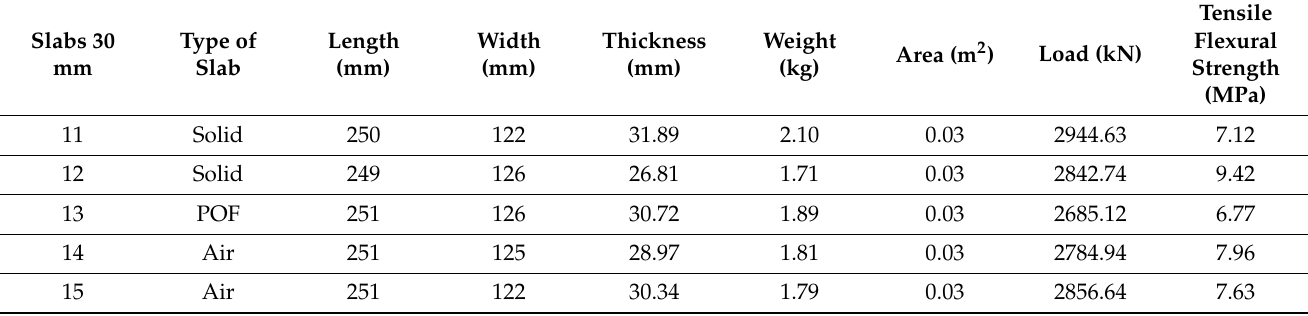
Table 14. Properties of slabs 30 mm thick for measuring tensile flexural strength.